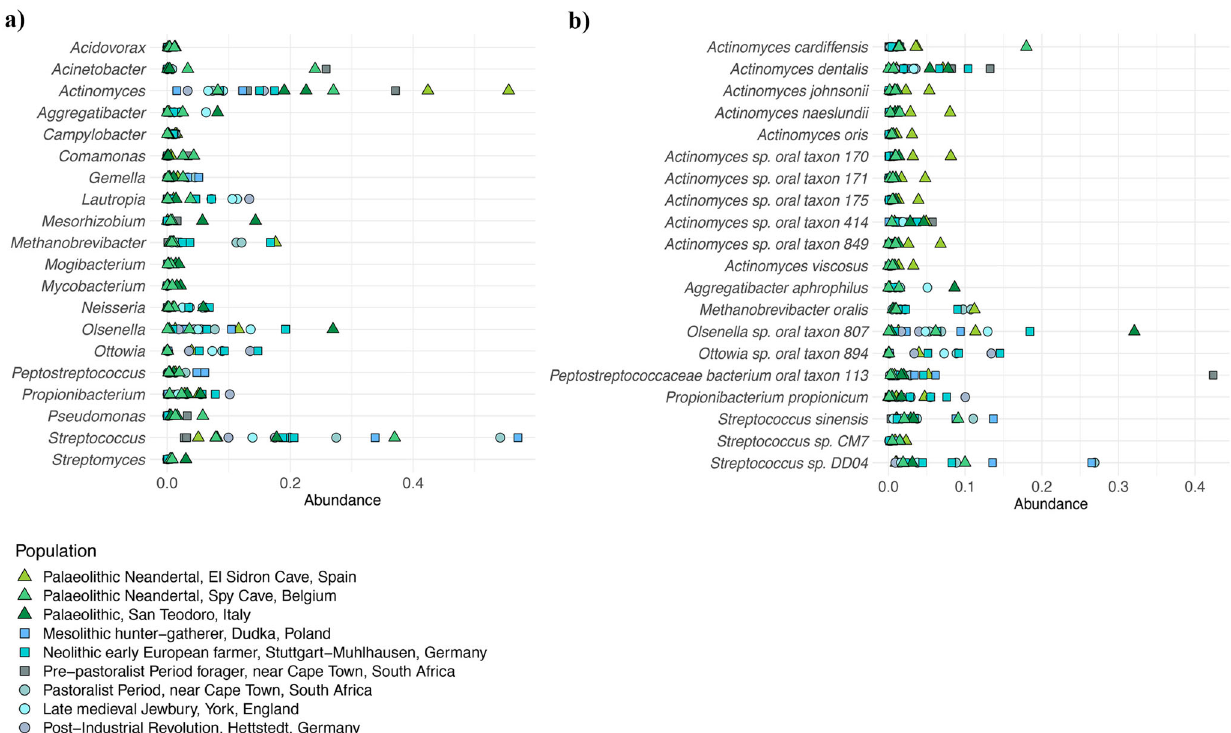
Fig. 3 Metagenomic composition of ancient dental calculus. Shown are estimated abundances of the top 20 most abundant genera ( a ) or species ( b ) across all ancient calculus samples (Supplementary Data 18 –